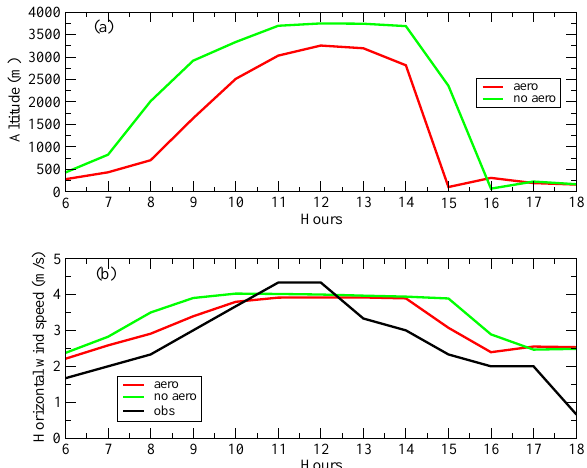
Fig. 10. (a) Temporal evolution of the atmospheric boundary layer (ABL) and (b) near-surface horizontal wind speed (in ms − 1 ) for 8 August, simulated with and without aerosols and measured at the Moscow meteorological station.